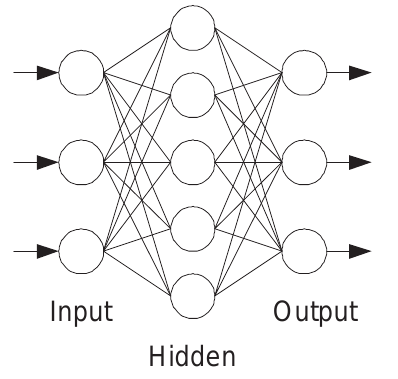
Figure 5. The structure of back-propagation neural